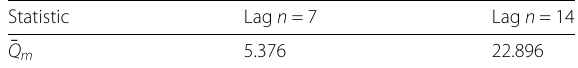
Table 4 Simulation results of portmanteau test statistic Statistic Lag n = 7 Lag n = 14 ¯ Q m 5.376